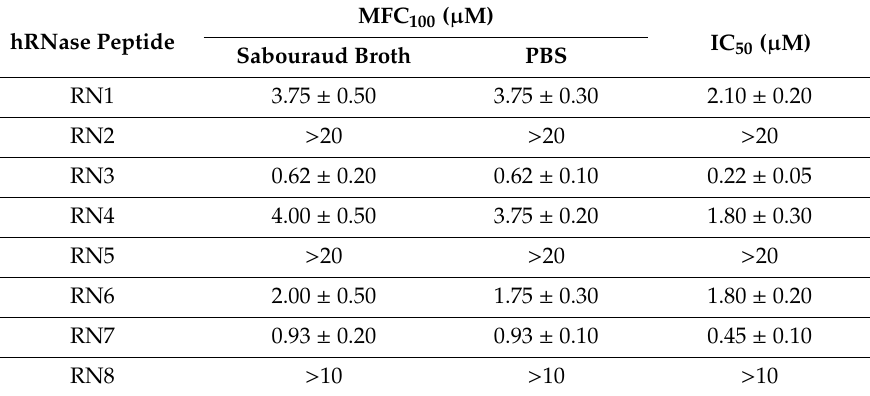
Table 2. Antifungal Activities of hRNases Peptides on C.